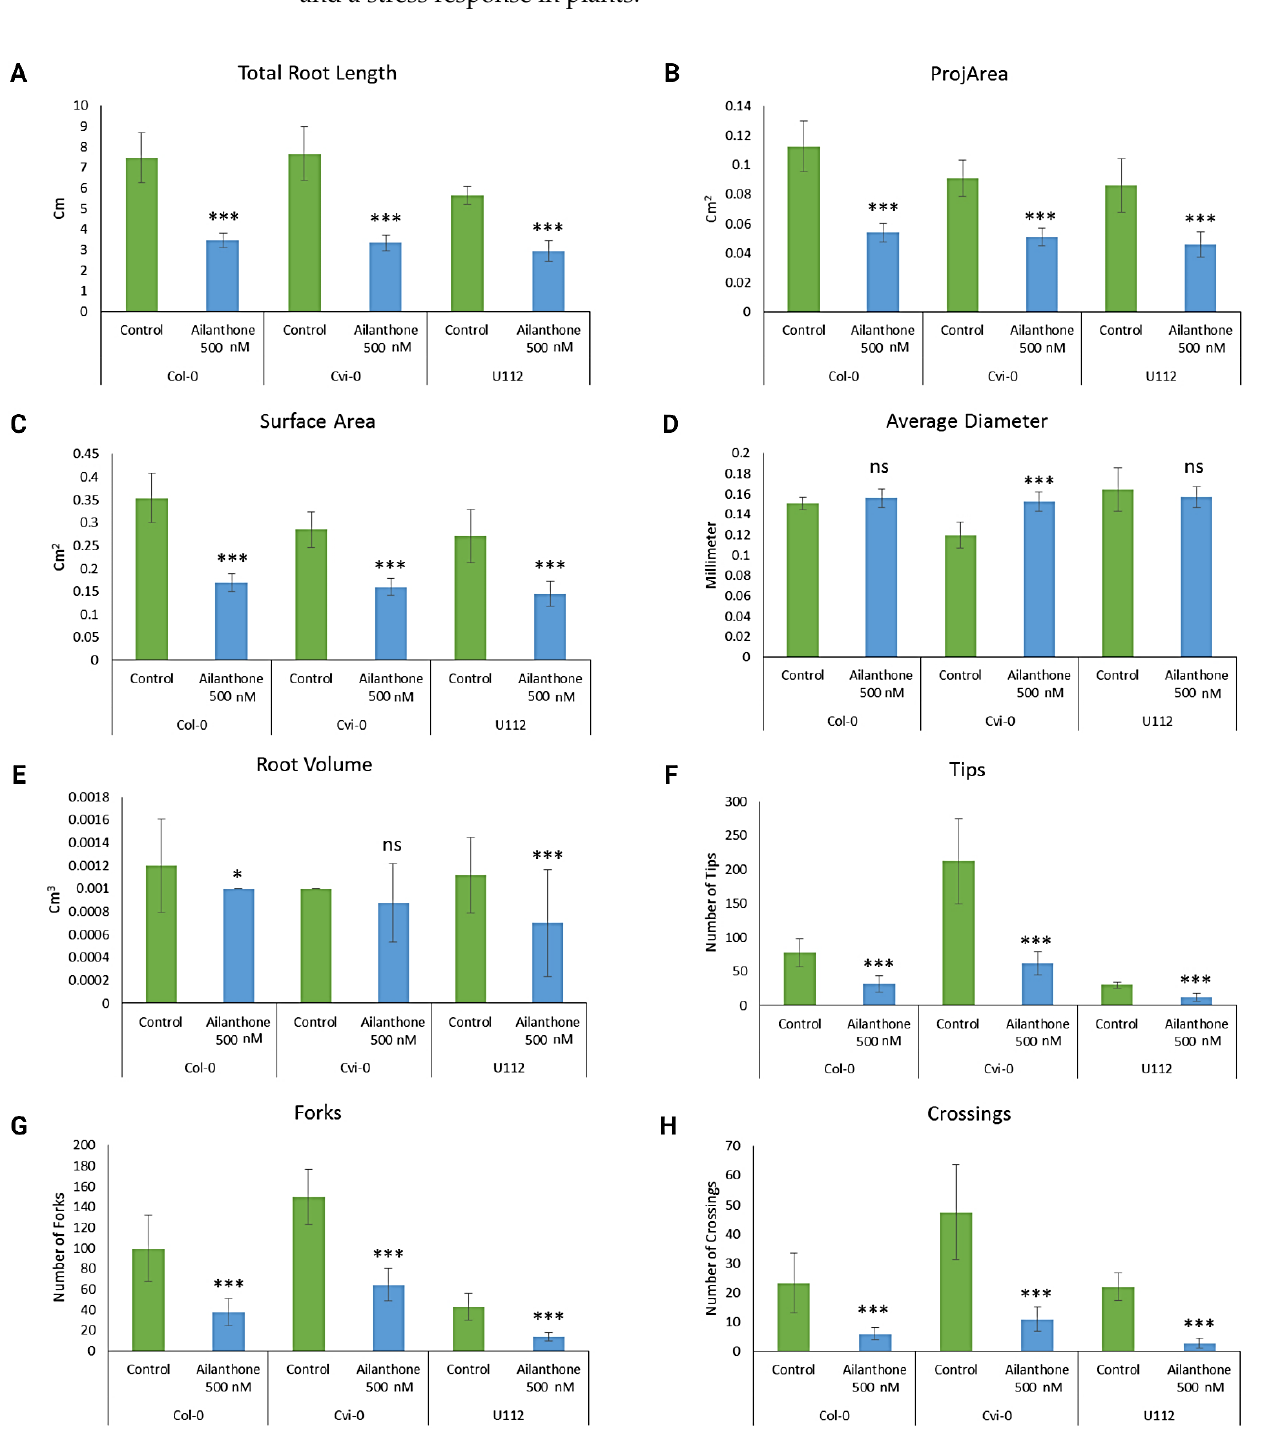
Figure 3. Effect of ailanthone on ( A ) primary root length, ( B ) root projected area, ( C ) root surface area, ( D ) root diameter, ( E ) root volume, ( F ) number of root tips, ( G ) number of root forks and ( H ) number of root crossings of the three ecotypes in control and treatment conditions. Data are mean SEM. *** p < 0.001; * p < 0.05; ns:non-significant. The overall primary root length was ~7.5 cm for the Col-0 control but ~4 cm for ailan- thone-treated Col-0 plants; Cvi-0 showed similar results to Col-0 in both control and treat- ment conditions (Figure 3A). U112-3 showed slightly smaller overall root length in both control (5 cm) and treatment (3 cm) conditions. Each ecotype showed ~50% primary root